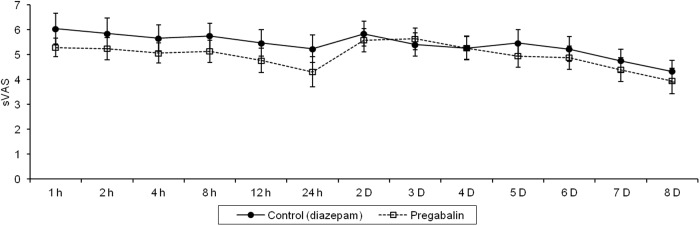
Visual analogue scale scores during swallowing (sVAS) after tonsillectomy in the control and pregabalin groups.Results are expressed as the mean score ± standard error (vertical bars represent standard error). There were no significant differences in the pain score between the two groups throughout the postoperative period. Abbreviation h: hour, D: day.